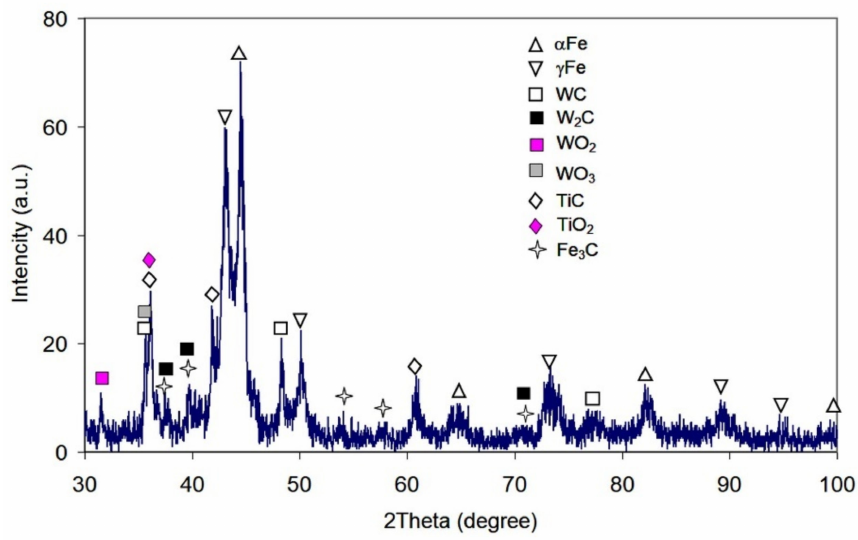
Figure 7. XRD pattern of the